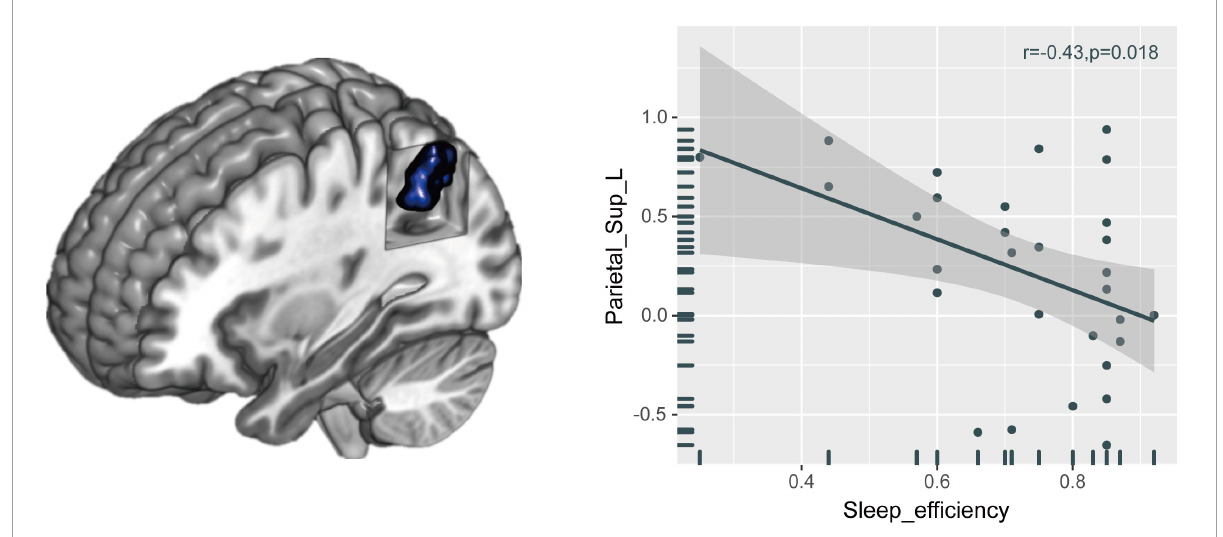
FIGURE3 Relationships between brain FCS alteration and neuropsychological performances in patients with CI. The FCS value of the left SPG was negatively correlated with sleep efficiency. FCS, functional connectivity strength; CI, chronic insomnia; SPG, superior parietal gyrus.